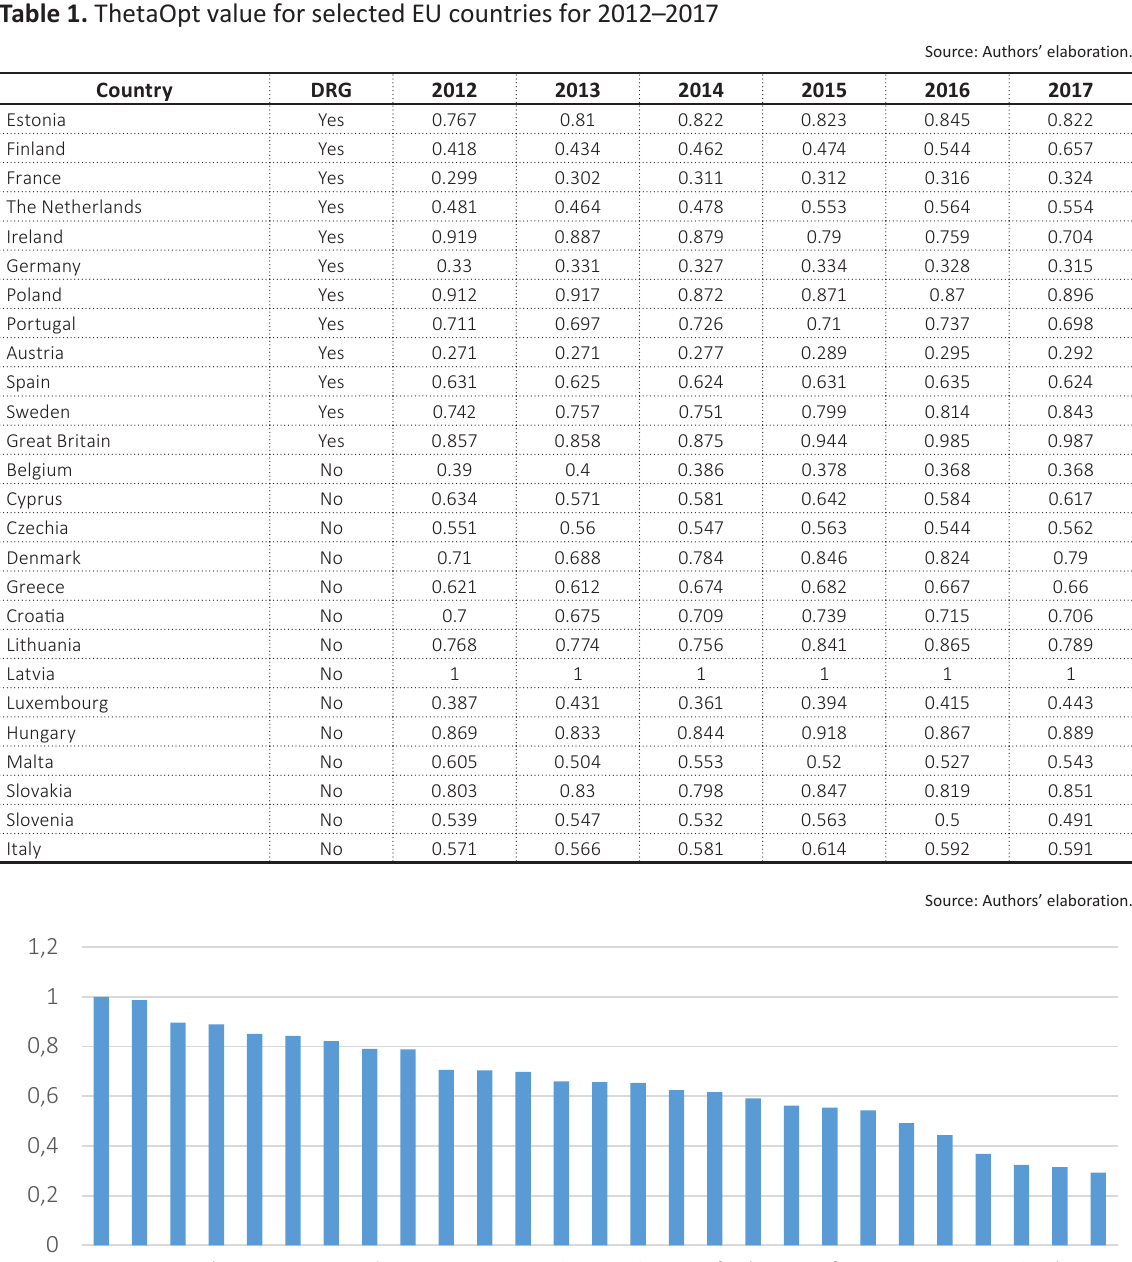
Table 1. ThetaOpt value for selected EU countries for 2012–2017